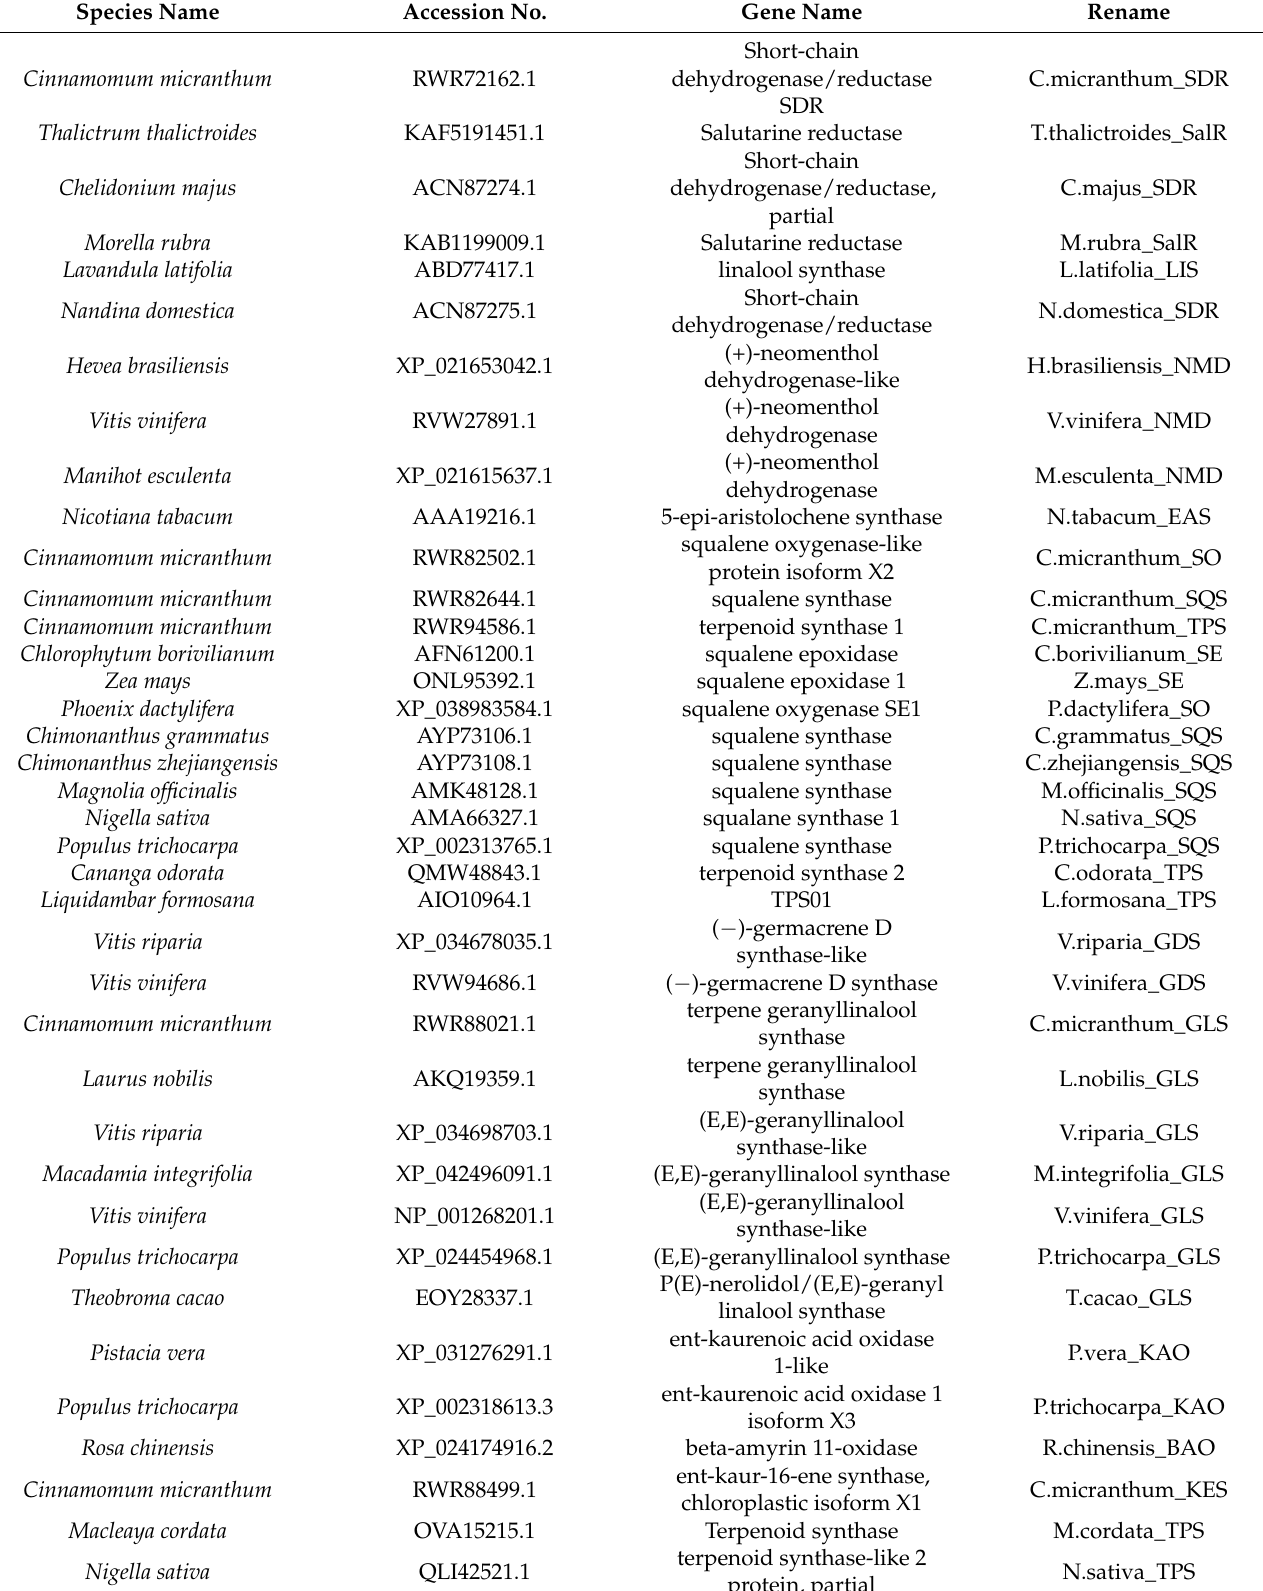
Table 5. Sequences involved in phylogenetic analysis other than C. burmannii